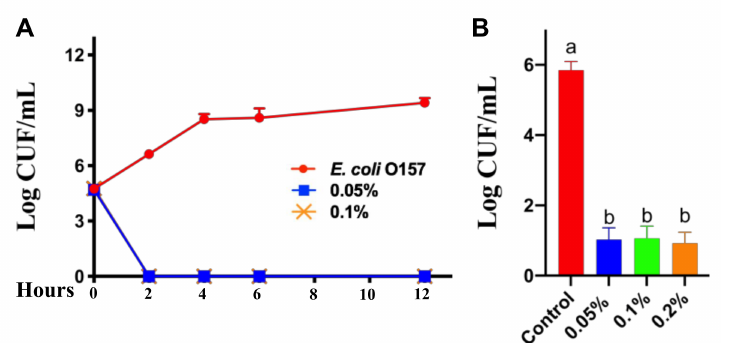
Figure 3. CNMs effectively inhibited E. coli O157 growth and adhesion to IPEC-J2 cells. ( A ) Bacterici- dal curves of CNMs against E. coli O157 in LB broth medium containing different concentrations of CNMs. ( B ) Monolayer IPEC-J2 cells were incubated with various levels of CNMs with or without E. coli O157 . The adhesion of E. coli O157 in IPEC-J2 cells was tested. Data are the means ± SEM of three independent experiments. Means with different lowercase letters differ significantly ( p <